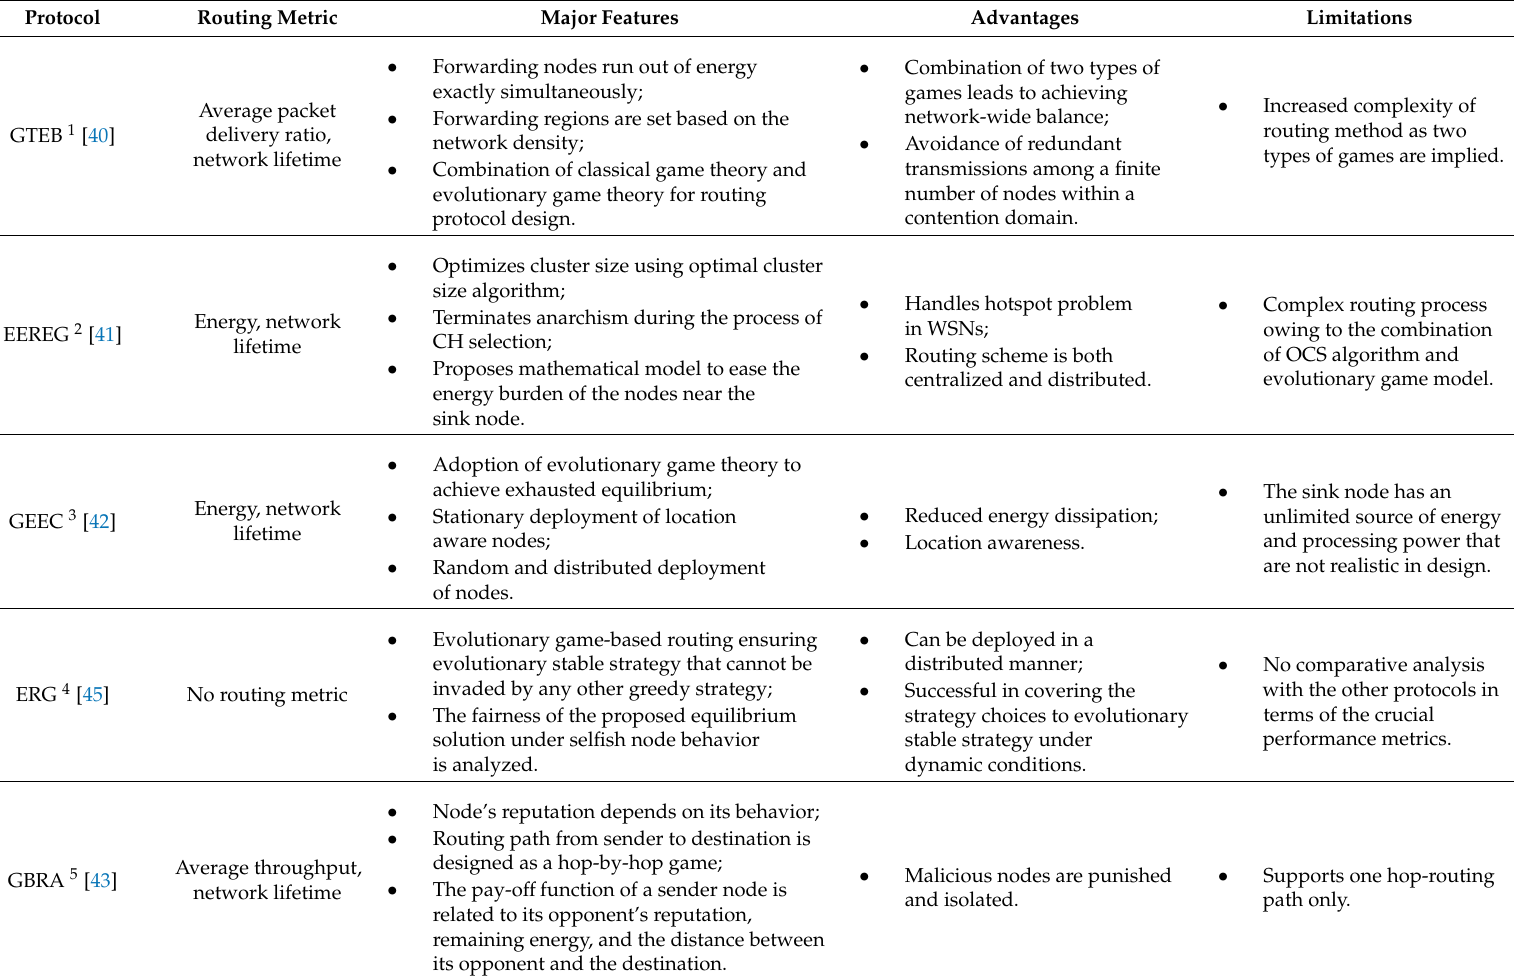
Table 9. Comparison of routing protocols based on evolutionary and reputation-based